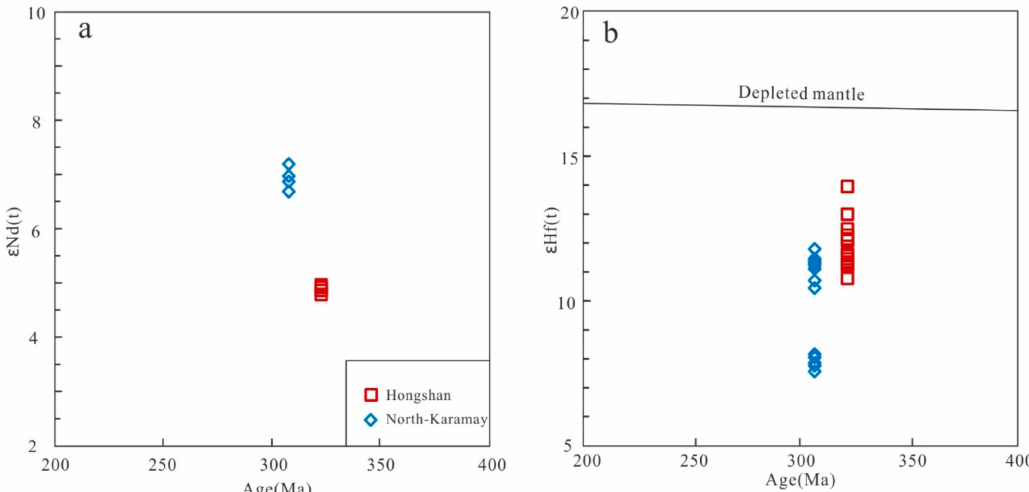
Figure 8. Plot of ( a ) Age- ε Nd(t) and ( b ) Age- ε Hf(t) diagram for the studied